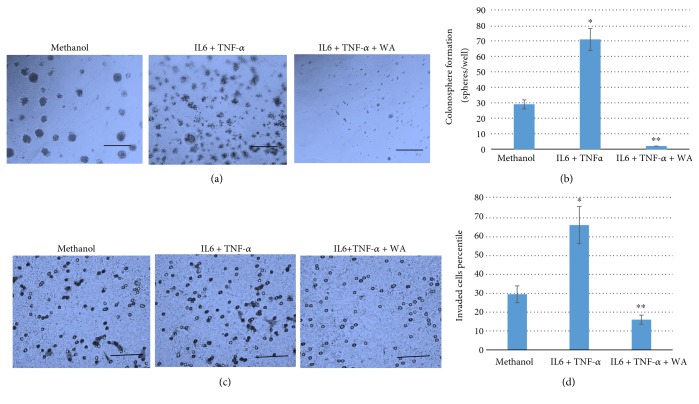
IL-6 and TNF-α cotreatments increased colonosphere formation and cell invasion whereas withaferin A decreased the sphere formation and cell invasiveness. (a) Colonosphere formation assay. DLD1 cells were cotreated with IL-6 and TNF-α for 24 hours, then subjected to the three-dimensional culture condition. Withaferin A (10 μM) was pretreated with IL-6 and TNF-α, then applied to three-dimensional culture. Representative images were taken after 7 days. Scale bar represents 50 μm in length. (b) Quantitative representation of colonospheres formed in IL-6 and TNF-α cotreatments in the absence and presence of withaferin A. ∗p < 0.05, ∗∗p < 0.01 versus untreated control. (c) Boyden chamber assay. Cell invasiveness was examined by employing Boyden chamber assay. Human colorectal cancer DLD1 cells were subjected to Boyden chamber cell invasion assay. Cells were treated with IL-6 and TNF-α in the absence or presence of withaferin A. Assays were done for 48 hours. Representative images were taken. Scale bar represents 50 μm in length. (d) The cell invasion assay was quantitatively measured in graphic representation. ∗p < 0.05, ∗∗p < 0.01 versus untreated control.